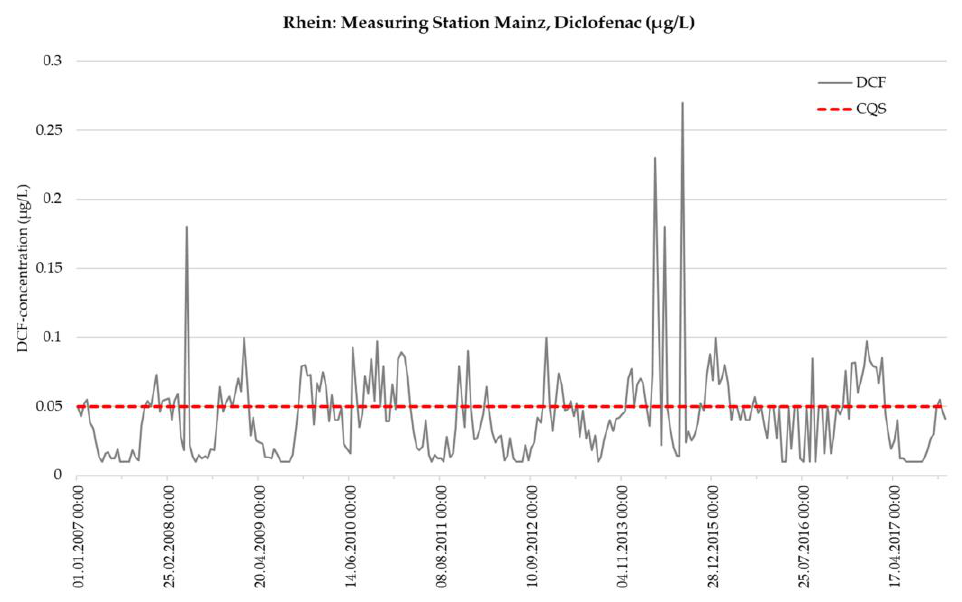
Figure 3. Concentrations of the analgetic diclofenac in the Rhine River [30].